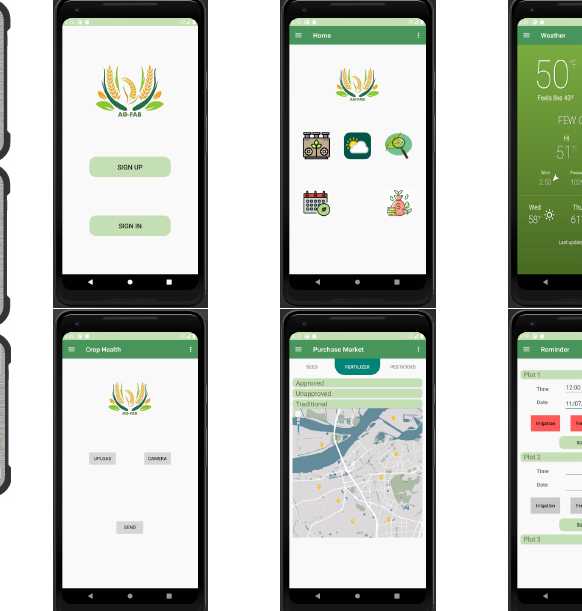
Figure 3. AgFAB Mobile App